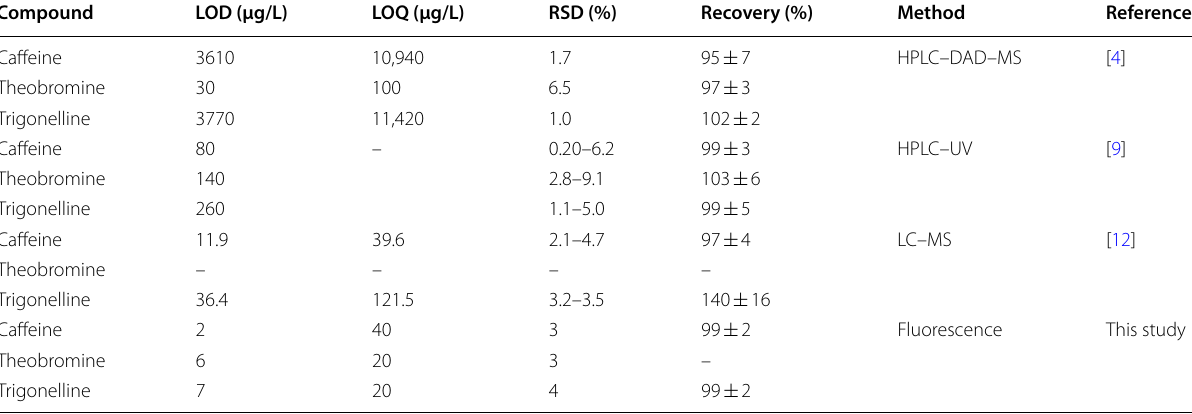
Table 3 Comparison of LOD, LOQ, RSD and percentage recovery of the developed method with the literature methods